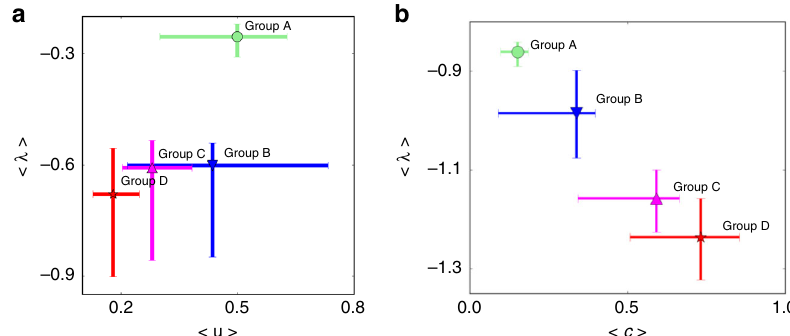
Fig. 2 Dynamics induced by network structure. a Average growth factor < λ > versus coupling percentage of urban population u i with α = 0.1, β = 0.2. b Average linear growth factor < λ > versus <c>. Note that all average values are done within each of the four different groups (A to D). Error bars indicate the maximum and minimum values for each group in Fig.